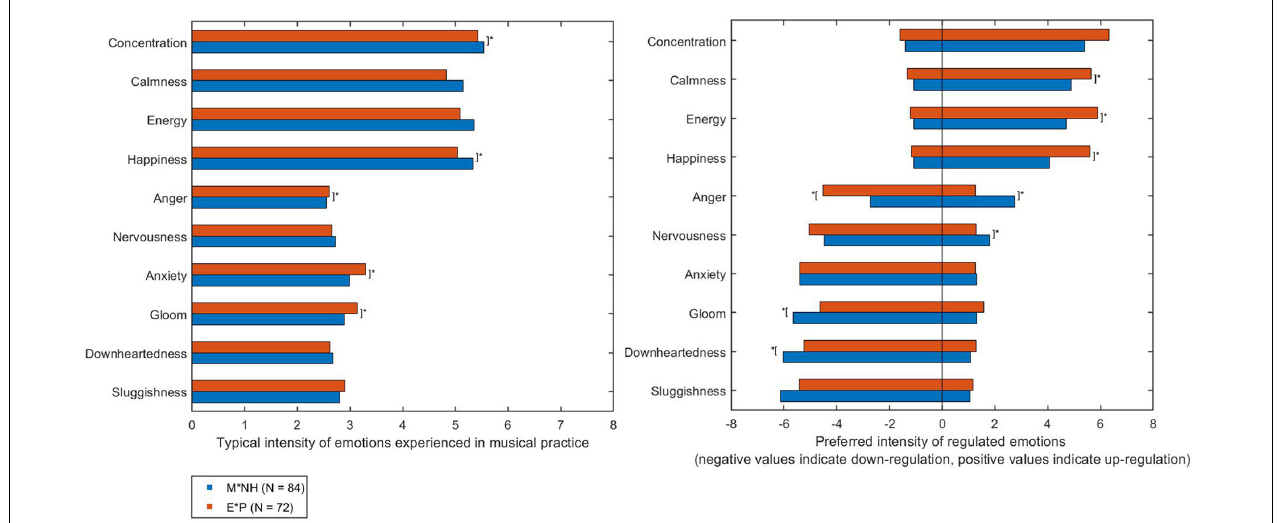
FIGURE 1 | Mean ratings for typical (left side plot) and regulated (right side plot) emotions in musical practice. Emotions were rated on a seven-point Likert scale (1 = not at all...7 = a great deal). Square brackets marked * indicate statistically significant differences between subgroups emotion ratings (Significant at the p < 0.01